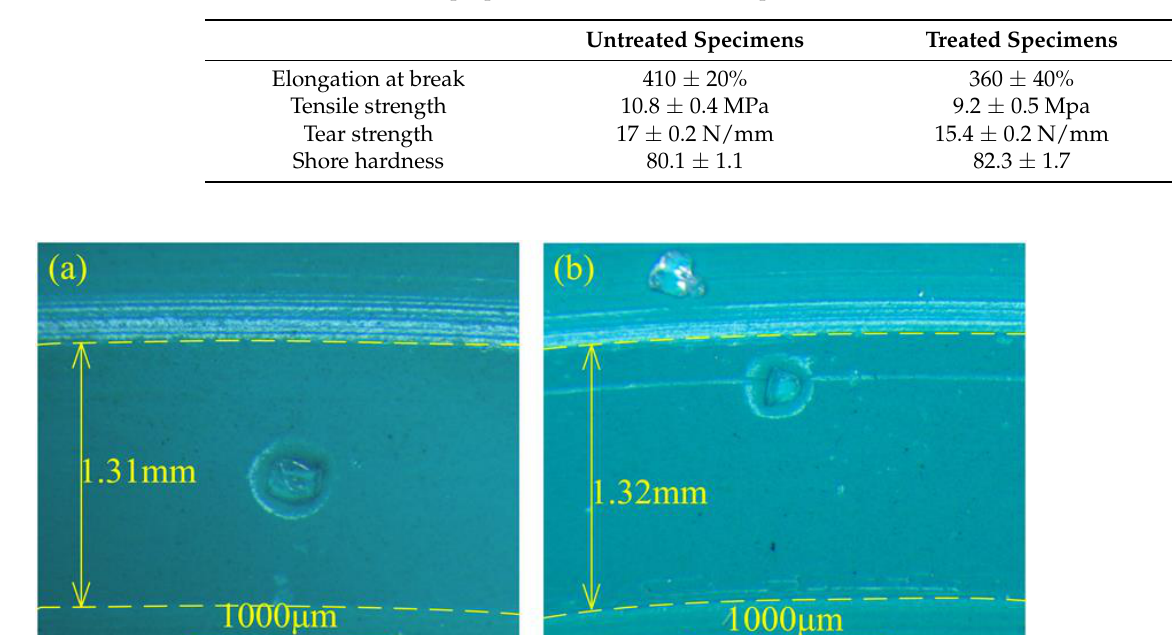
Table 2. The mechanical properties of the treated FKM specimens.